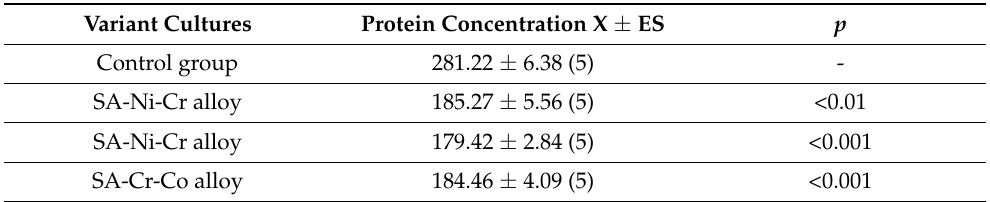
Table 1. Ionic diffuses made from various dental materials boost the protein concentration (µg pro- tein/culture) of monkey renal cell cultures that have been grown for 72 h.